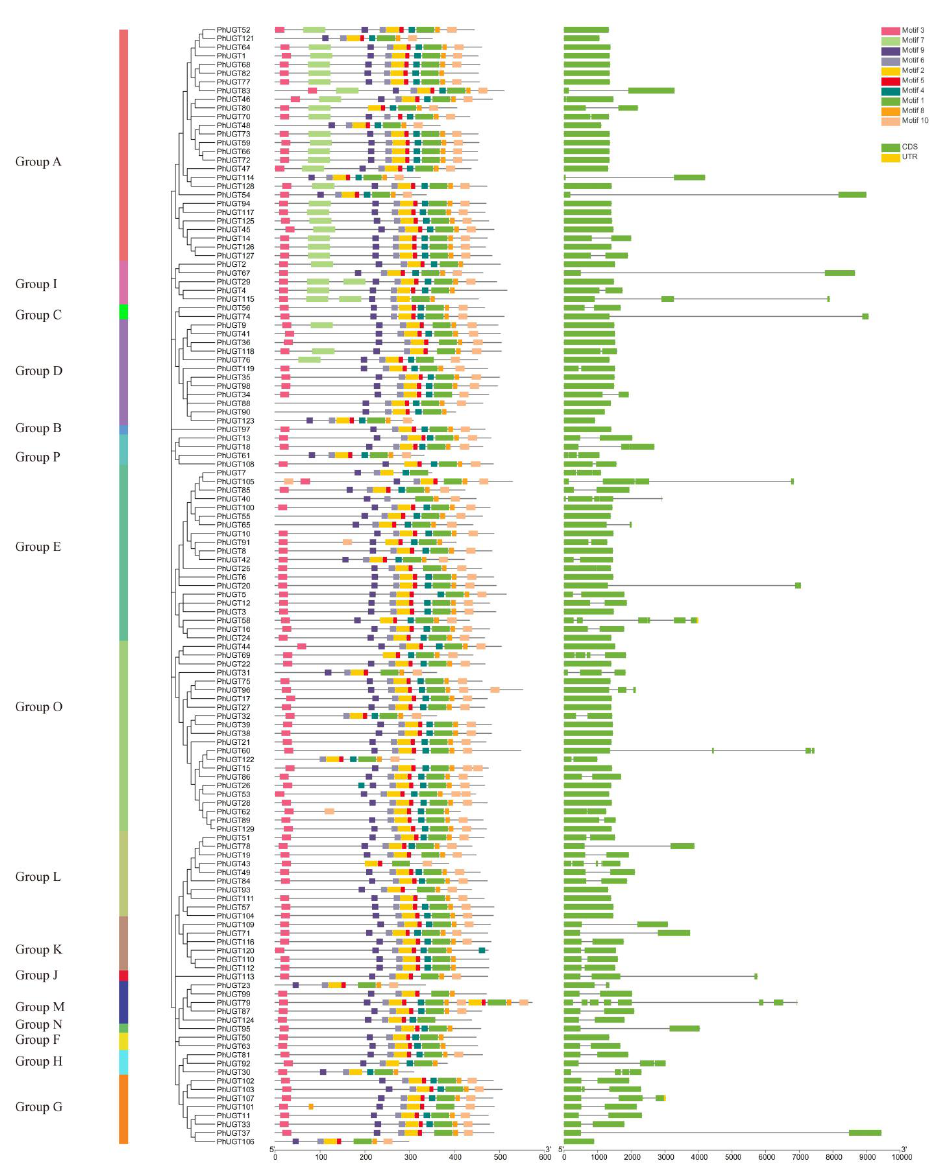
Figure 2. Conserved protein motifs and gene structure of PhUGT family members.